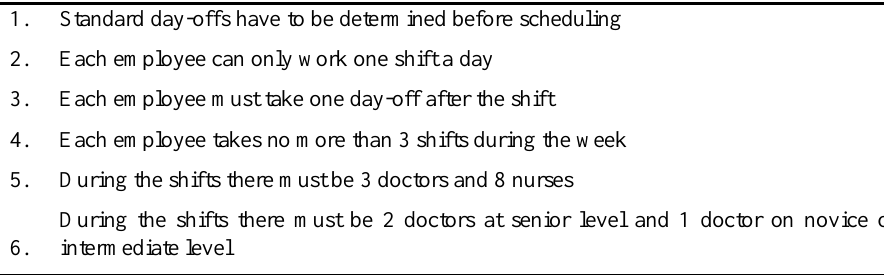
Table 1 – Hard constraints of scheduling